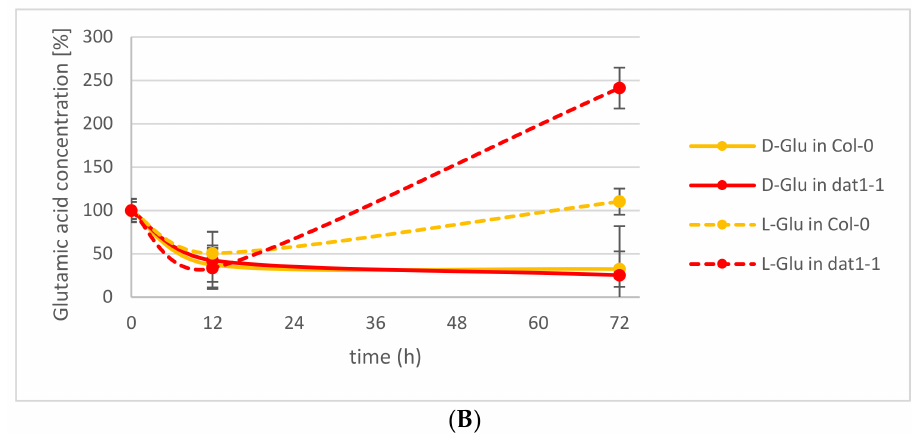
Figure 2. Relative alanine and glutamic acid concentrations in Col-0 wild-type and dat1 mutant line ( dat1-1 ) seedlings within 72 h. Seedlings were exogenously applied with ( A ) D -Ala and ( B ) D -Glu, and their D - and L -Ala or D - and L -Glu contents were determined, respectively. Solid lines mark the D -enantiomer; dotted lines the L -enantiomer. In ( A ), blue lines represent Ala from Col-0; green ones Ala from dat1-1 . In ( B ), yellow lines represent Glu from Col-0; red ones Glu from dat1-1 . Error bars: ± SD.